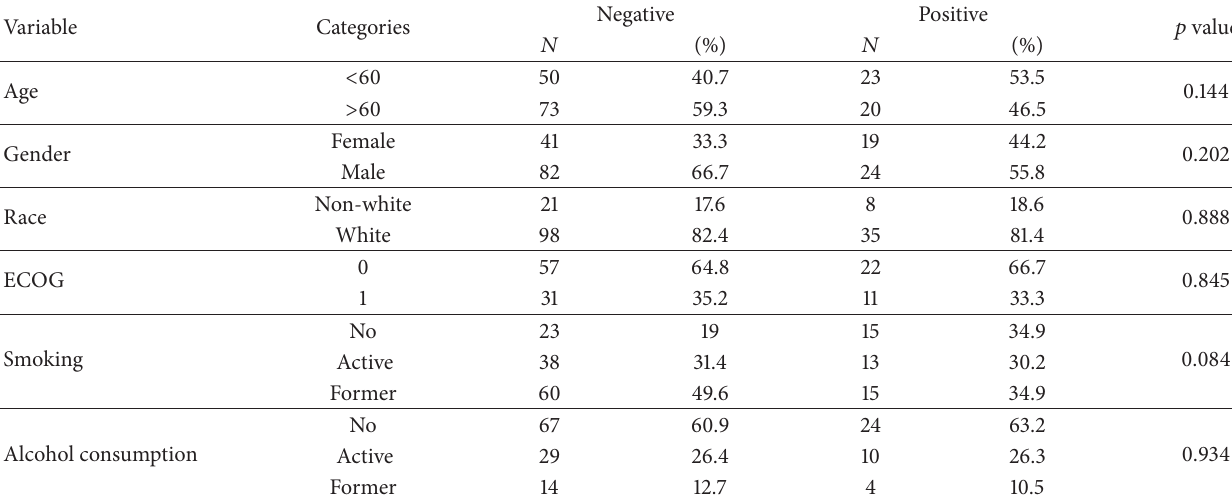
Table 7: PD-L1 expression in IICs and demographic